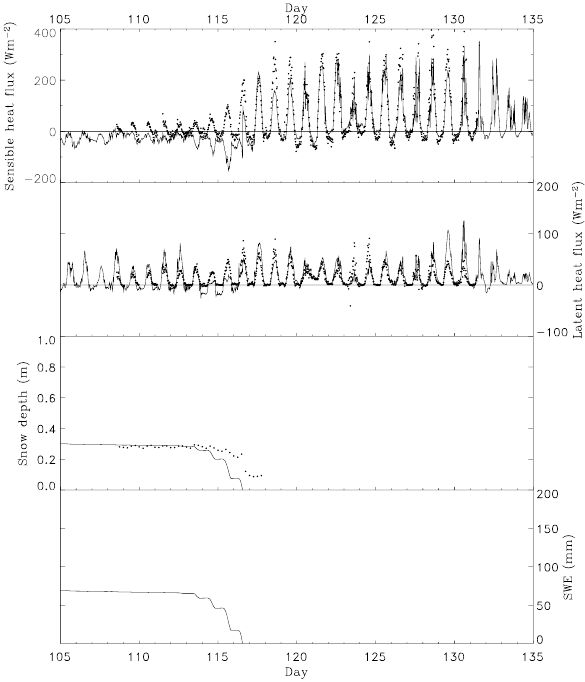
Fig. 6. Sensible and latent heat fluxes, snow depth and snow water equivalent for the plateau site in 2003. Dotted lines are automatic measurements, symbols are manual measurements and solid lines are model results discussed in Sect.